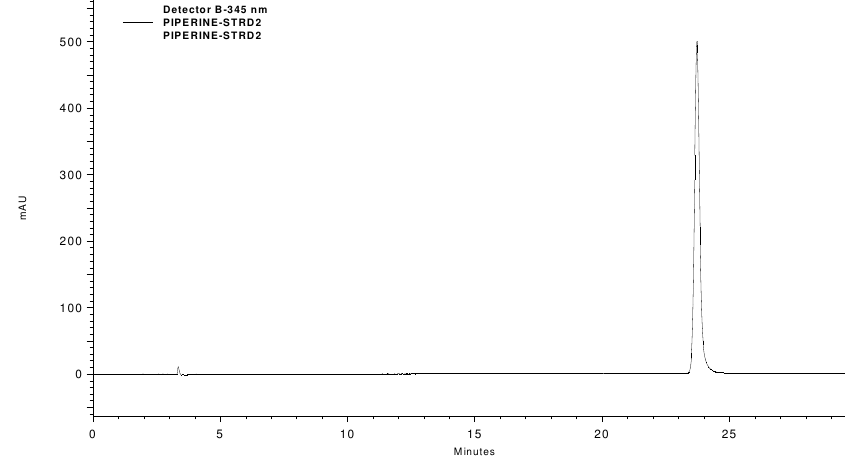
Figure 2 . HPLC chromatogram of pippalyadiyoga